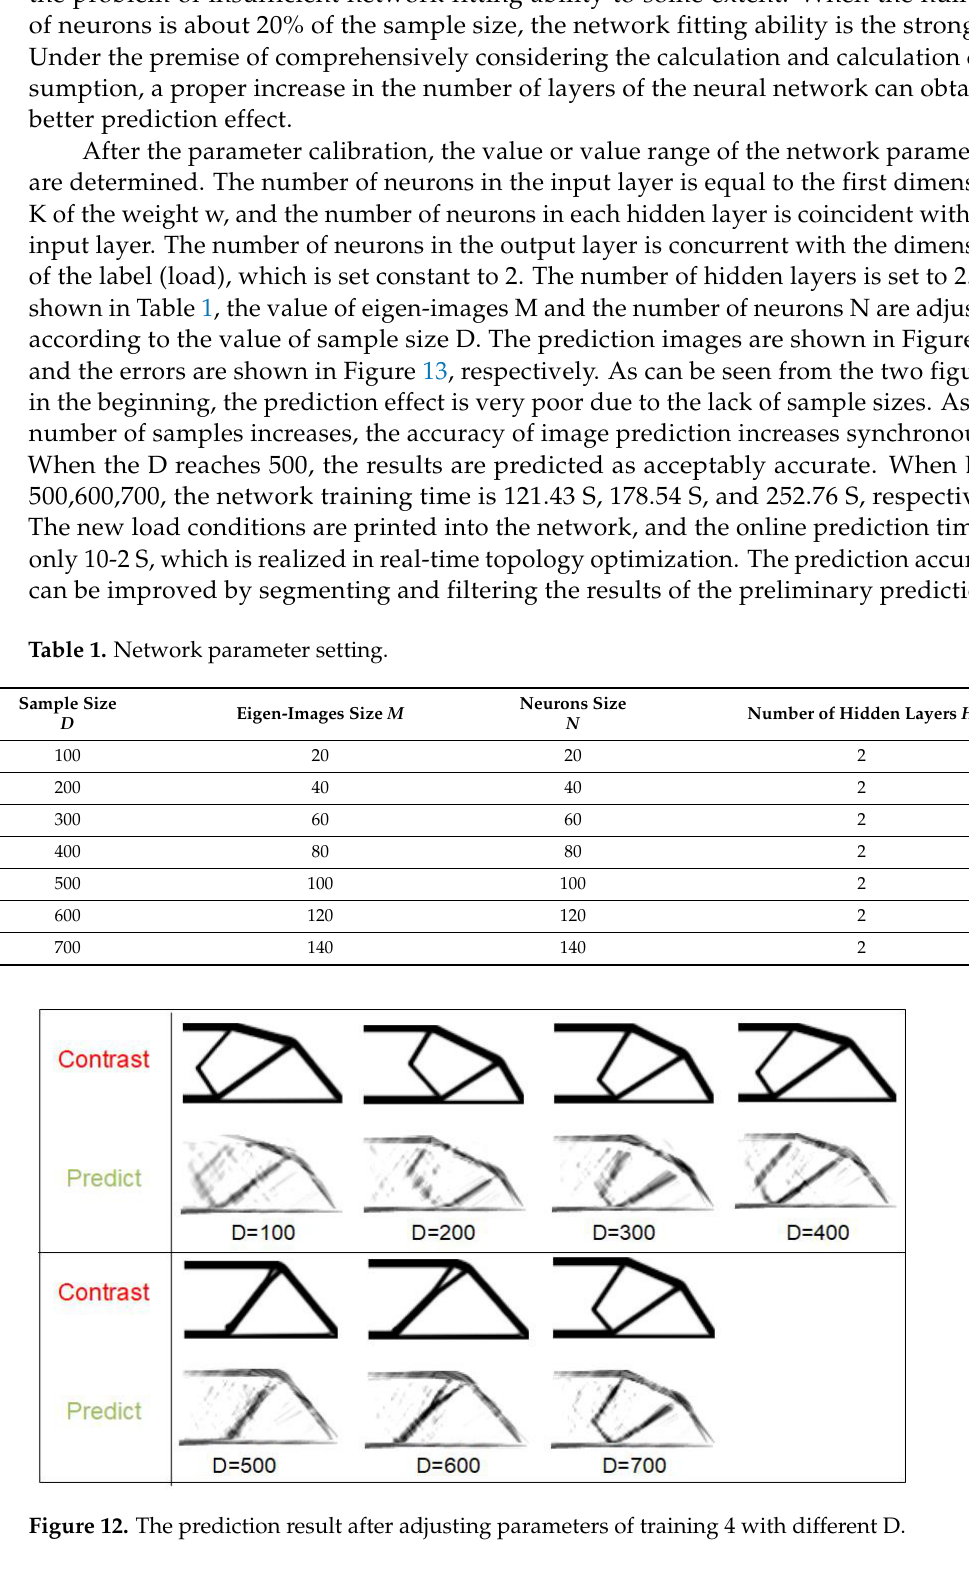
Figure 13. The influence of the sample size D on prediction accuracy.